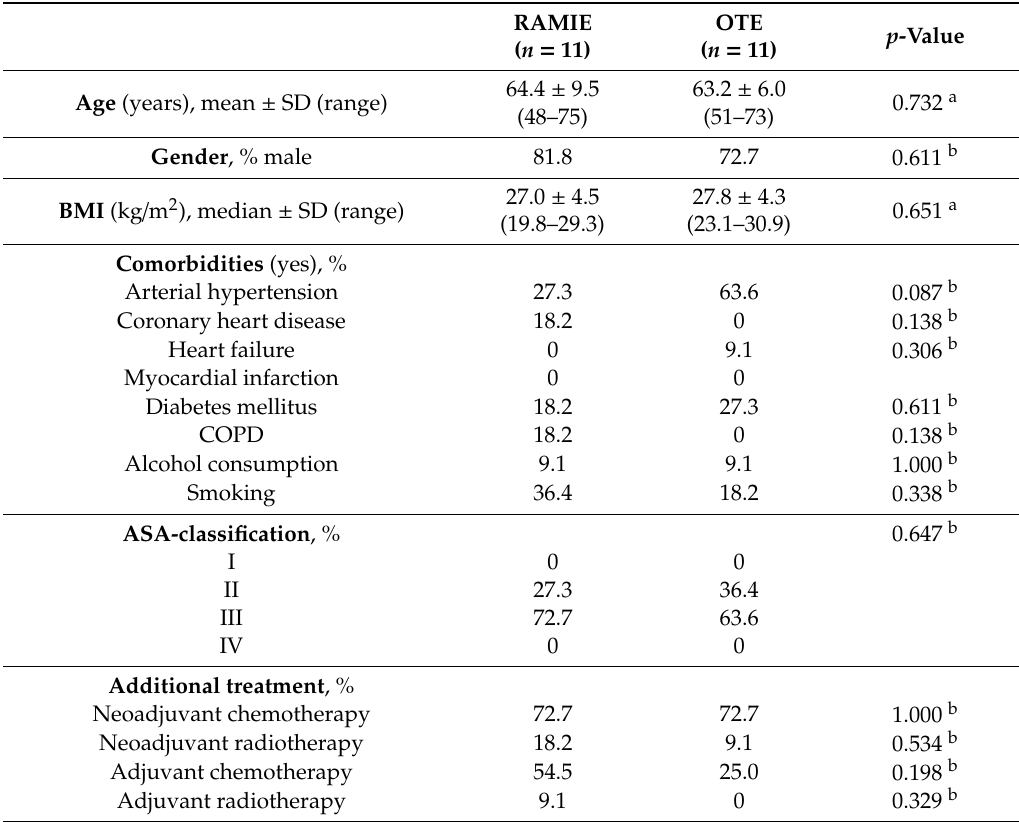
Table 3. Baseline comparison of patient characteristics in the propensity score-matched cohorts stratified by surgical approach (RAMIE vs.